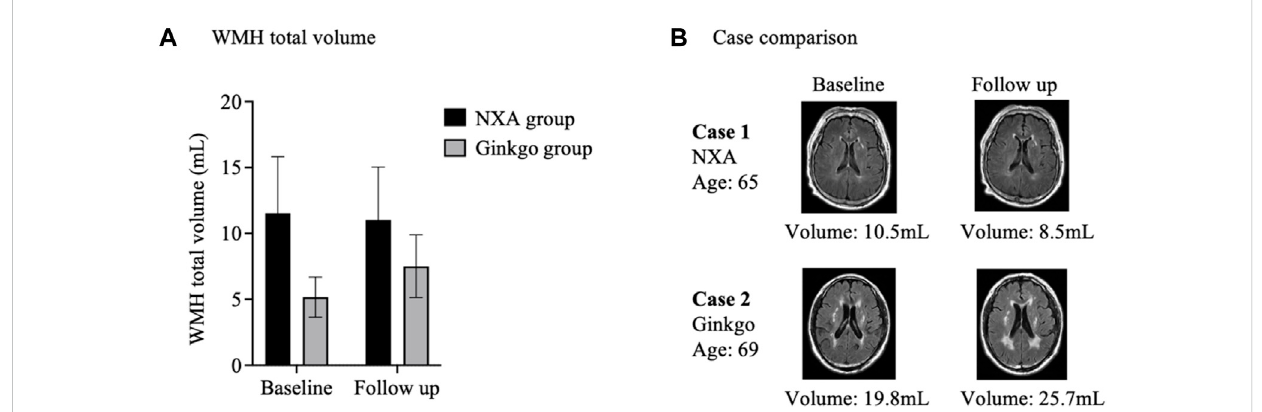
FIGURE 5 Effects of Naoxin ’ an capsule on white matter hyperintensity in patients with vascular cognitive impairment. (A) After treatment, the total volume of white matter hyperintensity showed a slight decrease in the NXA group and an increase in the ginkgo group but was not statistically signi fi cant ( p > 0.05). (B) White matter hyperintensitylesions inindividualsinthe NXA group and ginkgo group before andafter treatment. A 65-year-oldmale (baseline MMSE: 26)had adecreaseinthetotal volumeof whitematterhyperintensity from10.5 mL to 8.5 mL after Naoxin ’ an capsuletreatmentfor 24 weeks. A69-